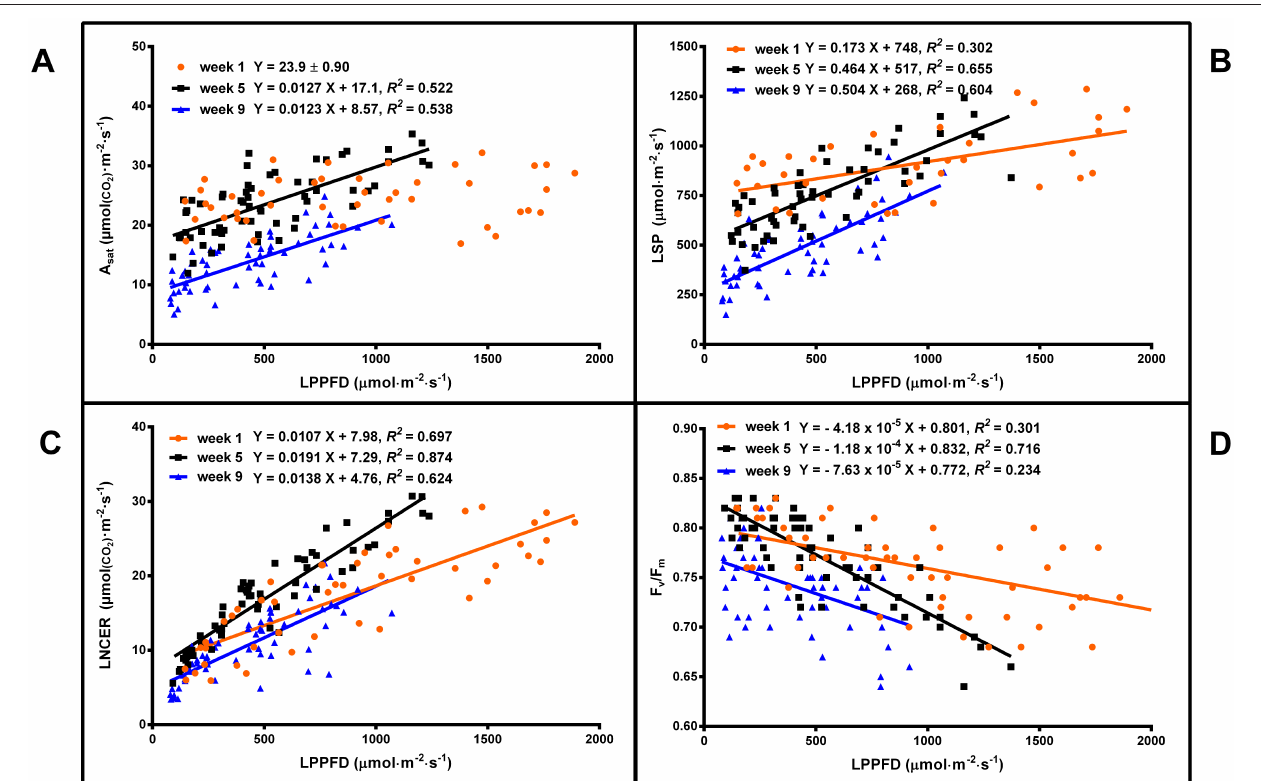
FIGURE 4 | The light-saturated net CO 2 exchange rate (A sat ) (A) , the light saturation point (LSP) (B) , the localized net CO 2 exchange rate (LNCER) (C) , and the F v /F m (D) of the youngest fully-expanded fan leaves of Cannabis sativa ‘Stillwater’ at the localized photosynthetic photon flux densities (LPPFD) that the respective leaves were growing under when the measurements were made, during weeks 1, 5, and 9 after initiation of the 12-h photoperiod. Each datum is a single plant. Regression lines are presented when P ≤ 0.05.